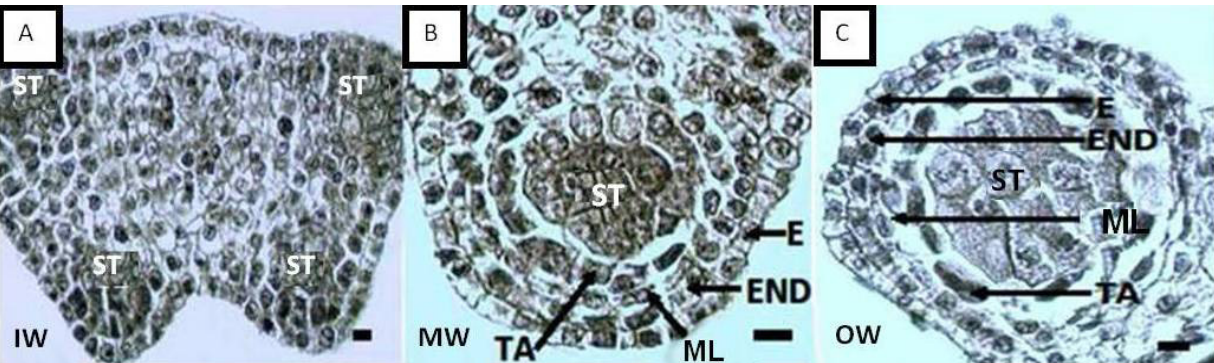
Fig. 8. Anthers of hermaphrodite florets in inner, medial and outer whorl of the same capitulum in H. annuus (in transverse section). A. The anther become slightlyl lobed and sporogenous tissue started to become visible in the floret of the inner whorl; B. Well- arranged anther wall layers and tapetal cells in the floret of medial whorl; C. Tapetal cells undergoing divisions in the floret of outer whorl. E: Epidermis; END: Endothecium; IW: Inner whorl floret; ML: Middle layer; MW: Medial whorl floret; OW: Outer whorl floret; ST: Sporogenous tissue; TA: Tapetum. Bar: 10 μm